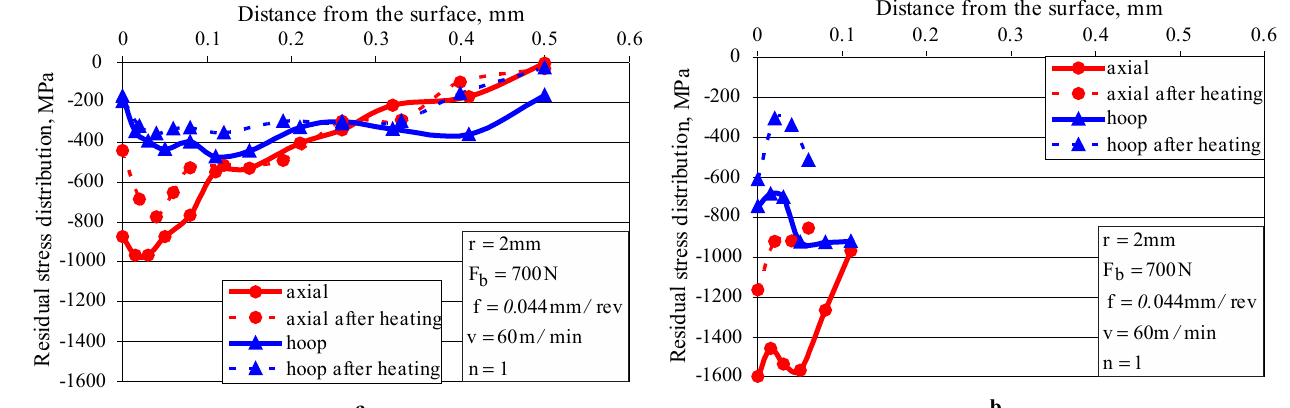
Figure 19. Residual stress relaxation due to heating (at 450 ◦ C for two hours): ( a ) austenitic phase; ( b ) martensitic phase.